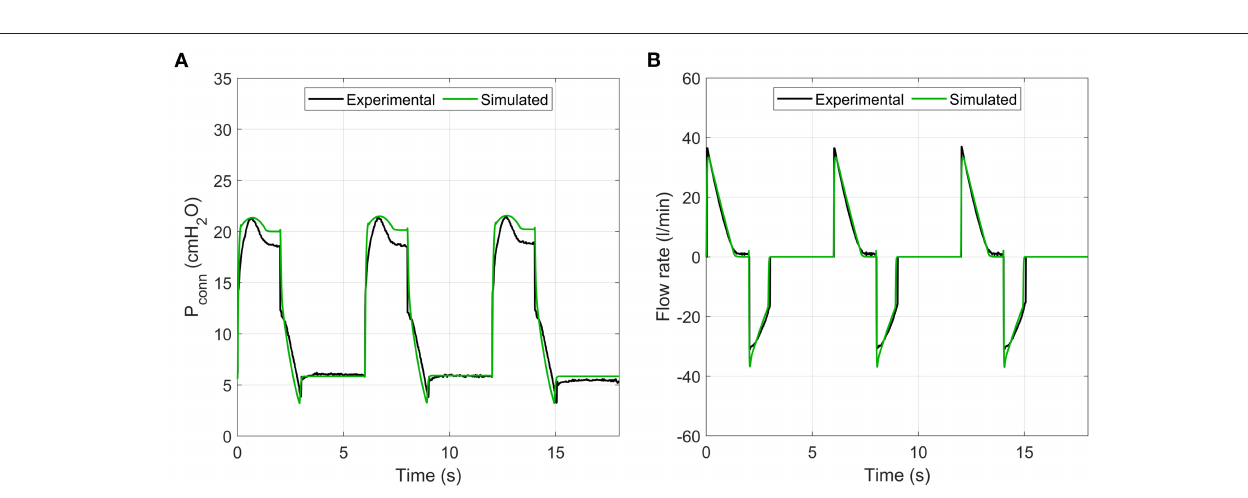
FIGURE 9 | Sample comparison of pressure and flow rate traces between experimental prototype and numerical model. (A) pressure, (B) flow